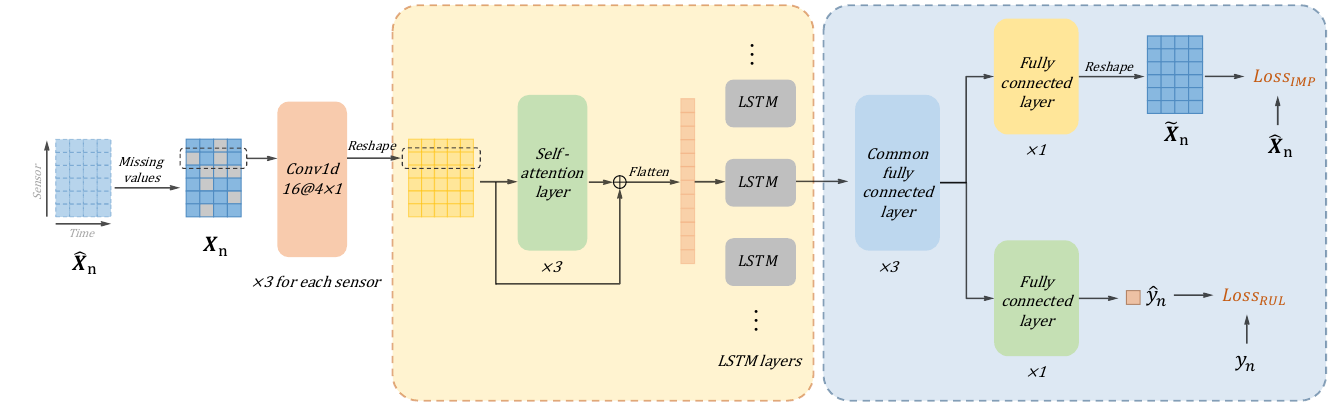
Figure 1. The architecture of the proposed